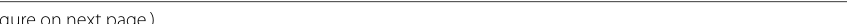
figure on next Fig. 5 qPCR and immunoblotting showed changes in the hnRNPC C2 level in NPCs and hippocampus of Nhlrc2 FINCA/ − mouse. a qPCR results of the three protein transcripts; Ftl1 , Anxa6 , and Hnrnpc, showed significantly changed RNA levels in Nhlrc2 FINCA/ − (square) compared to Nhlrc2 + / + (round) NPCs, 80% (p 0.035), 75%, (p 0.023), and 70% (p 0.012) respectively (Student’s t-test). Expression was normalized against one wild-type = = = sample. Individual data points, group mean, and SEM are shown. b SDS-PAGE immunoblot and measured protein levels of three Nhlrc2 − / − and Nhlrc2 FINCA/ − NPC lysates revealed increased hnRNP C2 (165% p 0.045). c SDS-PAGE immunoblot and measured protein levels from 13-week-old = female Nhlrc2 FINCA/ − and wild-type hippocampal tissue lysates showed increased hnRNP C2 (820%, p 0.046). hnRNP C2-specific antibody was = used and the expected size of hnRNP C2 is 34.4 kDa. d SDS-PAGE immunoblot and measured protein levels from 5-week-old male Nhlrc2 FINCA/ − and wild-type hippocampal tissue lysates for myelin basic protein (MBP) and myelin associated glycoprotein (MAG). MAG was significantly decreased in Nhlrc2 FINCA/ − (69%, p 0,027). Protein amounts are relative to one of the wild-type samples and GAPDH was used for normalization. Individual data = points, group mean, and SEM are shown. Statistical analysis was done using Student’s t-test *p <